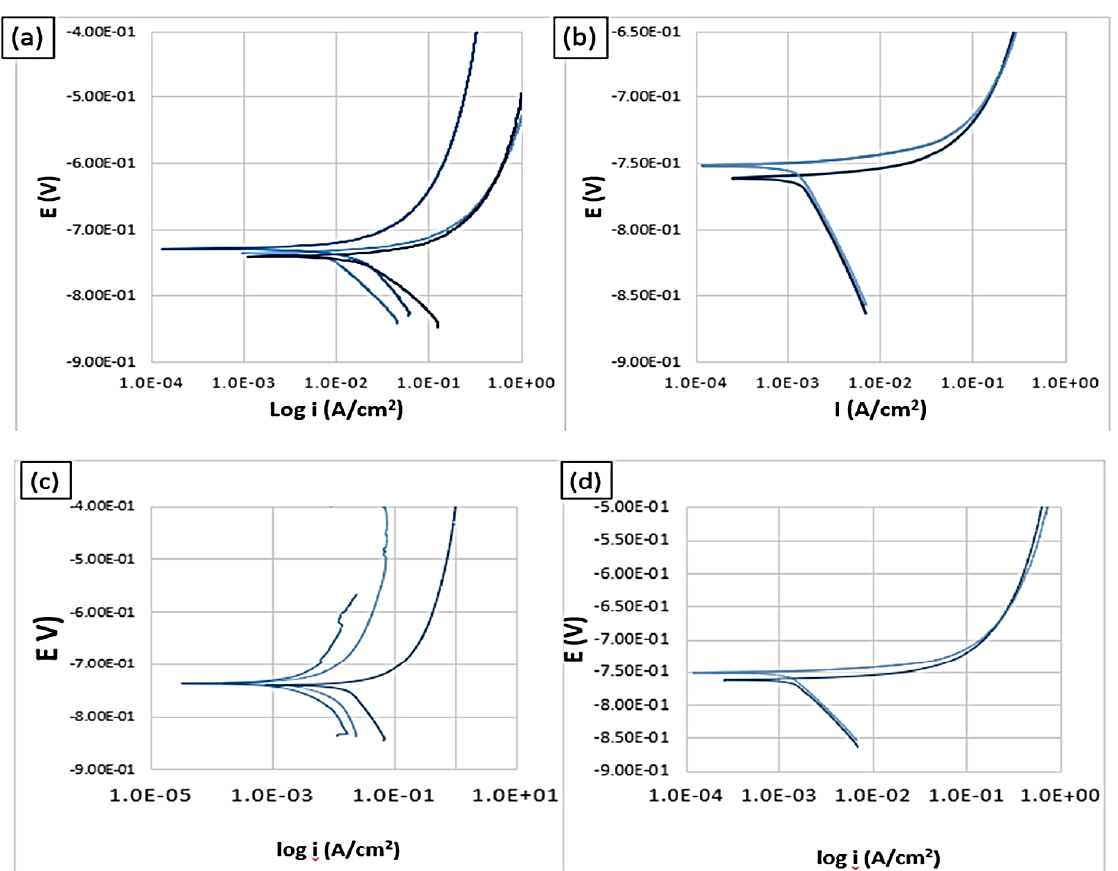
Figure 5: Potentiodynamic curves for 6xxx Aluminium cast samples cooled in (A) air) b) room temperature (b) mould in ice black) c) in mould at 140°C.(d) cooled in mould at 230 °C.